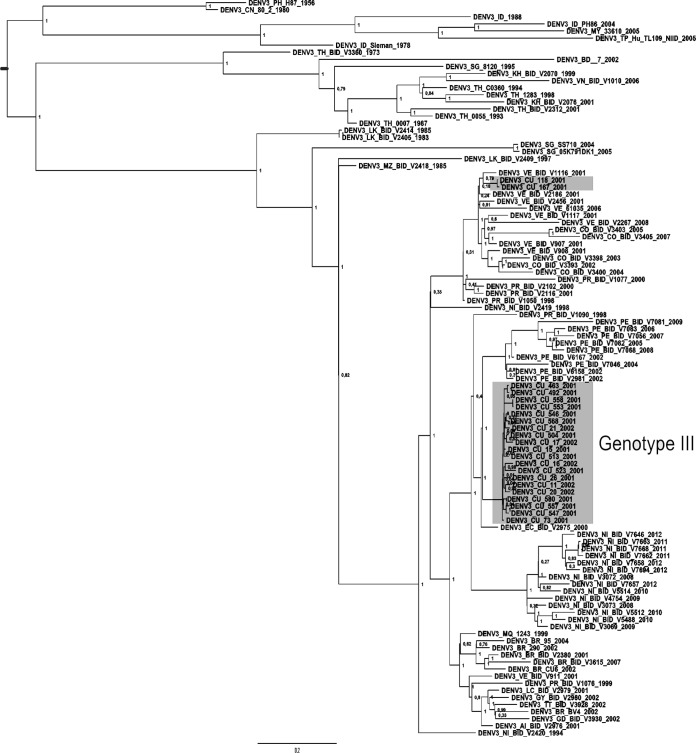
Bayesian phylogeny of the DENV-3 polyprotein data set, including Cuban isolates from the 2001-2002 epidemic highlighted in gray. All horizontal branch lengths are drawn to scale. Bar, 0.02 substitutions per site. The tree is midpoint rooted for purposes of clarity only.